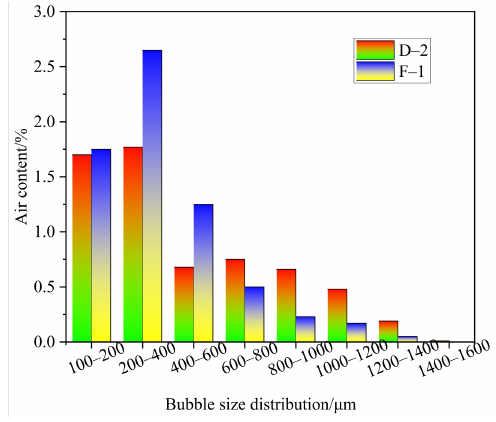
Figure 23. Air void and bubble size distribution.